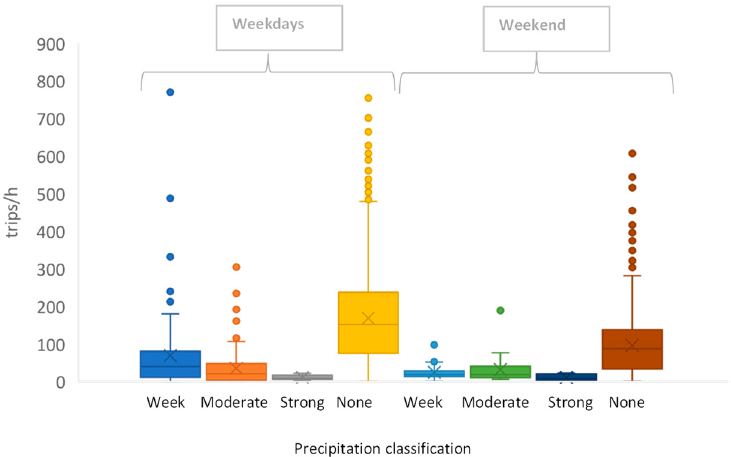
Figure 11. Precipitation events and hourly number of trips.